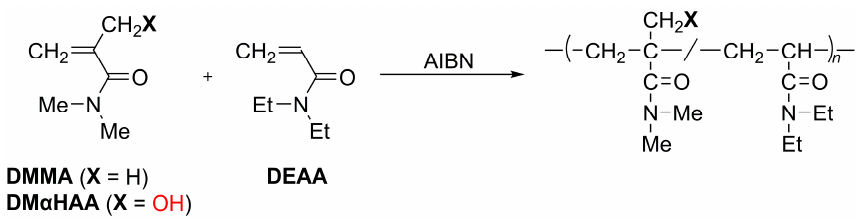
Scheme 1. Radical (co)polymerization of DMMA and DM α HAA with DEAA.